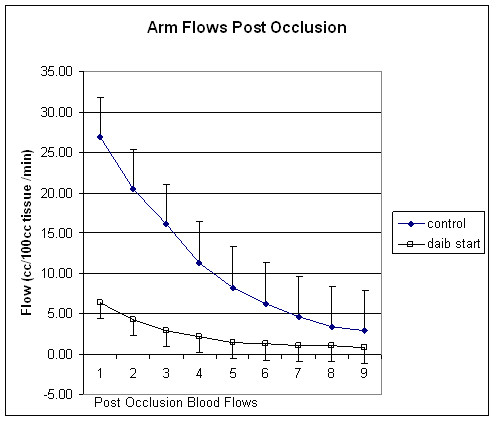
This figure shows the blood flow recorded for 2 minutes following the release of an arterial occlusion cuff on the brachial artery in control subjects (diamonds) and subjects with diabetes (squares). Illustrated here are the average results for all subjects in each group +/- standard deviation. Flows are expressed in cc/100 ml muscle per minute and the time scale on the bottom is the flow number. Flows are recorded every 12 seconds starting at 3 seconds post occlusion.